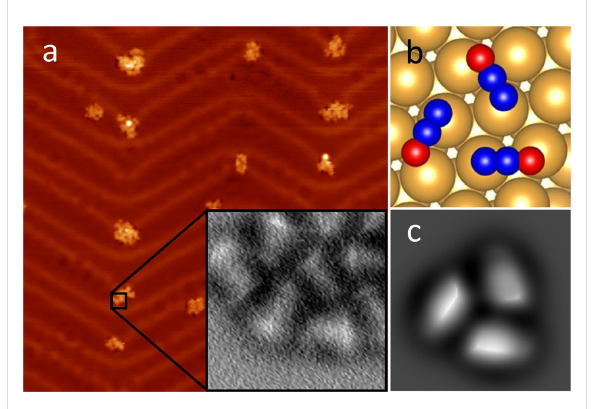
Figure 1: Adsorption of N 2 O molecules on the Au(111) substrate. (a) Overview STM image (100 mV, 10 pA, 50 × 50 nm 2 ) of a sample after N 2 O deposition. Inset: a close-up AFM image (1.5 × 1.5 nm 2 ) of the N 2 O cluster adsorbed on the herringbone elbow, scanned with a CO-functionalized tip. (b) Top view of the calculated adsorption geom- etry of a N 2 O trimer. (c) Simulated AFM image (1.5 × 1.5 nm 2 ) of a N 2 O trimer on Au (111) using the probe-particle model